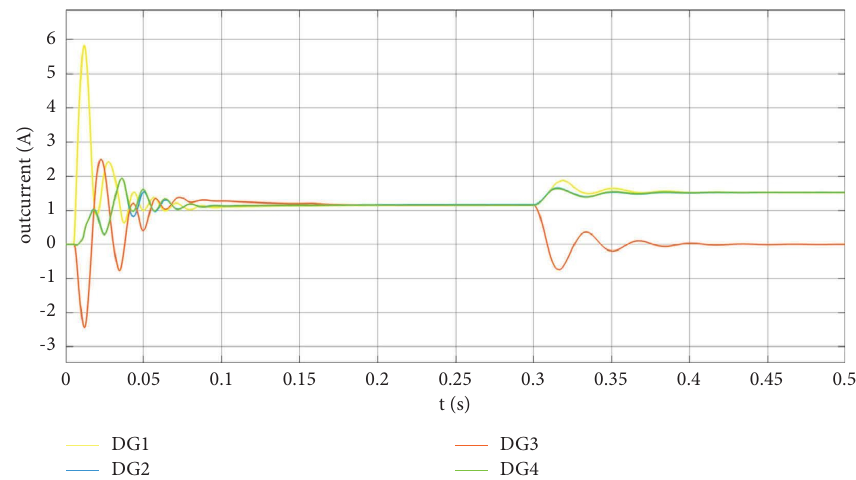
Figure 12: Output current of each unit after converter # 3 is disconnected.